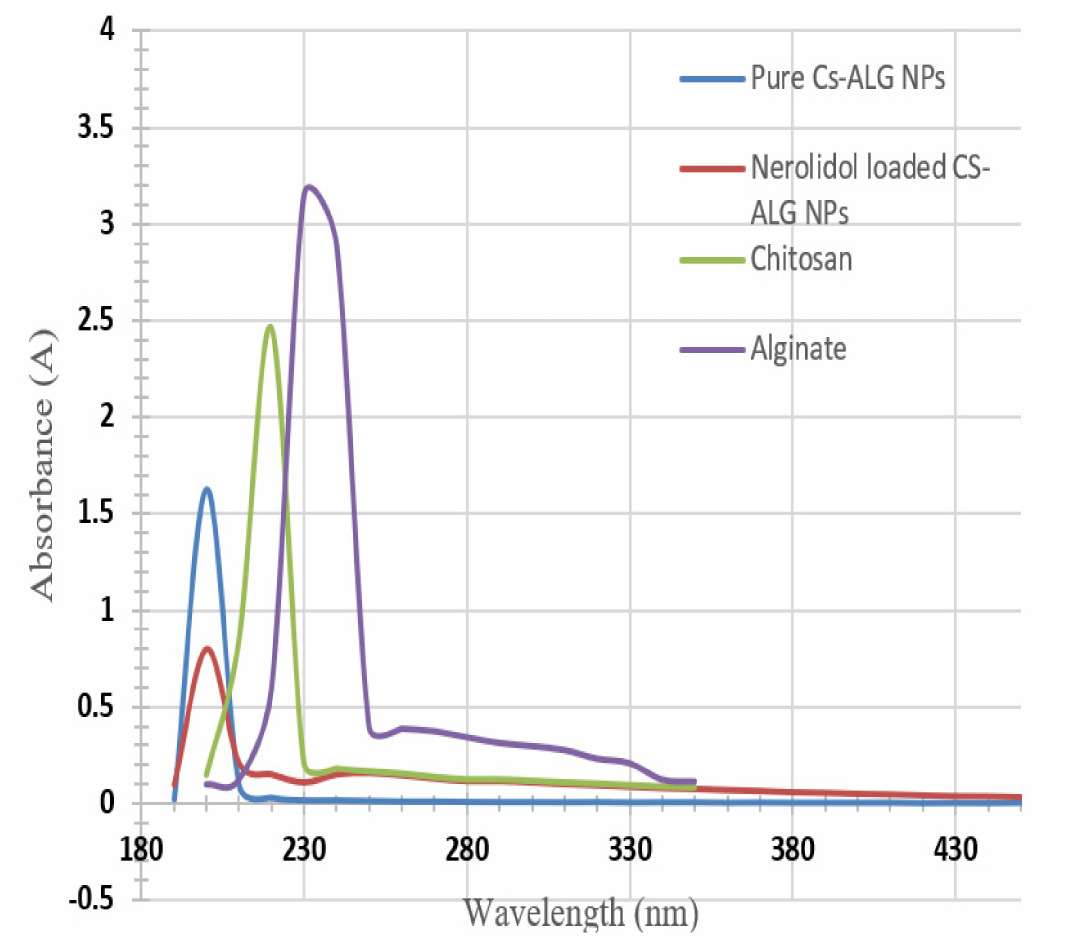
Figure 3. The UV-spectroscopy graphs for chitosan, alginate, blank, and nerolidol-loaded chitosan- alginate